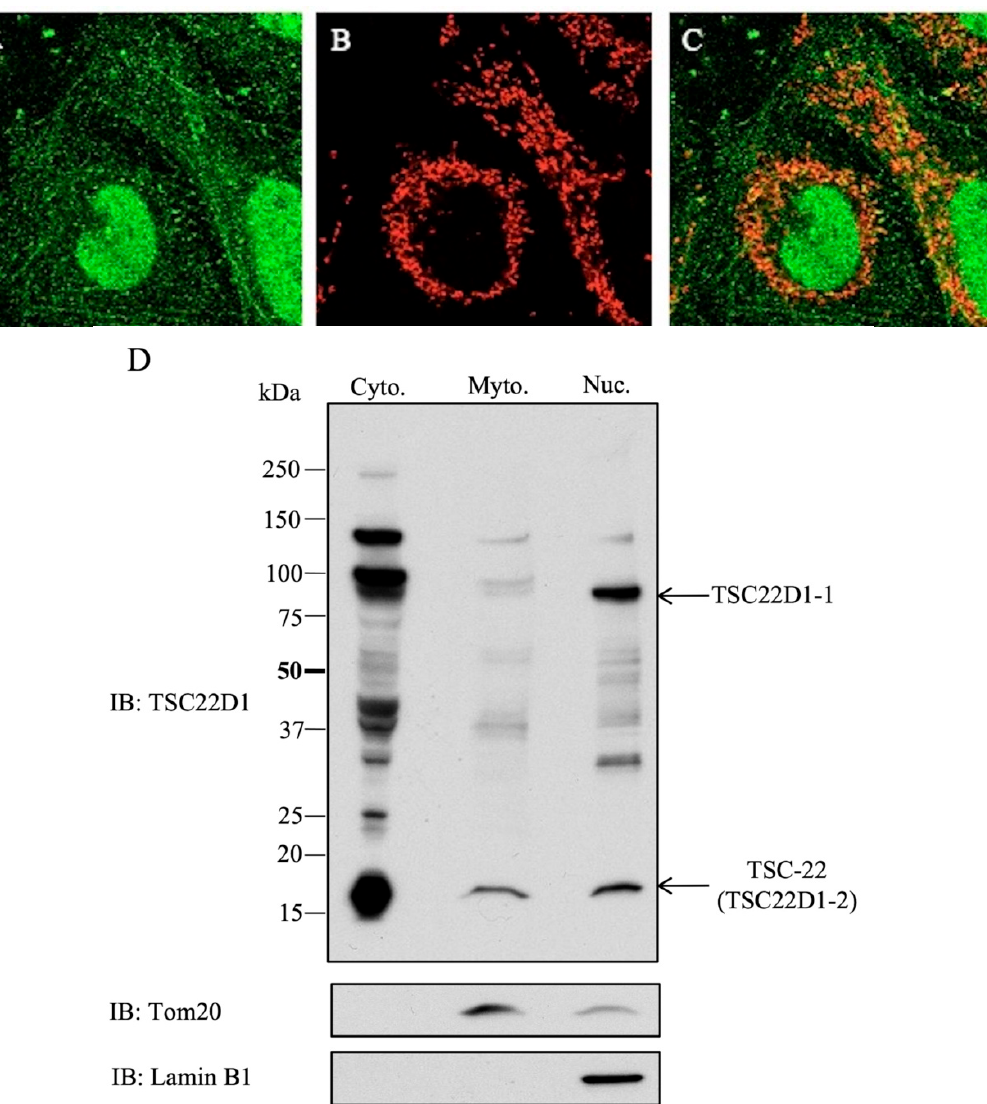
Figure 5. Intracellular localization of endogenous TSC22D1 proteins. ( A ): Fluorescence antibody method using anti- TSC22D1 antibody. HEK293 cells showed fluorescence as dots in the cytoplasm and nuclear fluorescence due to endogenous TSC22. ( B ): Localization of a mitochondrial marker, Tim50. ( C ): Merging of TSC22D1 and TIM50. ( D ): Western blotting using mitochondrial and nuclear fractions of HEK293 cells.